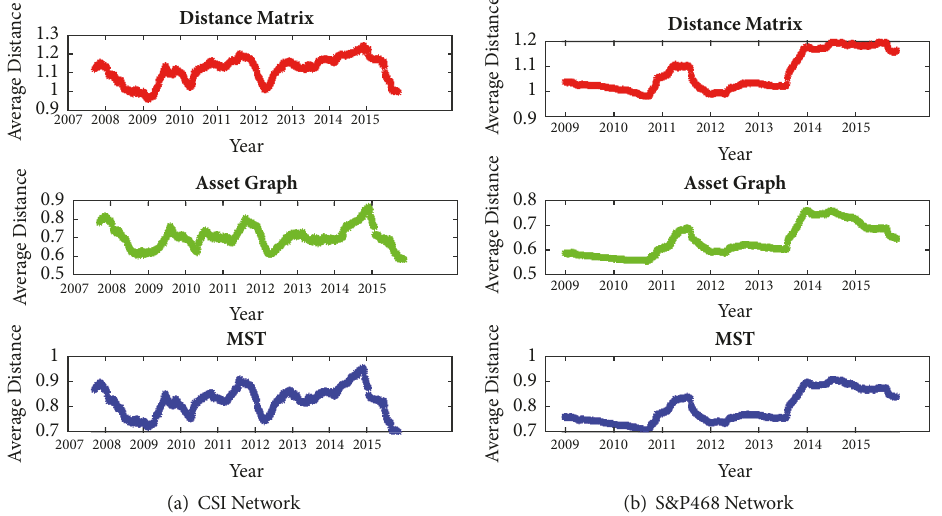
Figure 24: The evolving of average distances ⟨𝑑 𝑖𝑗 ⟩ of original network 𝑁 𝑡 , asset graph 𝐴𝐺 𝑡 , and minimum spanning tree 𝑀𝑆𝑇 𝑡 for CSI163 and S&P468 over time in the study